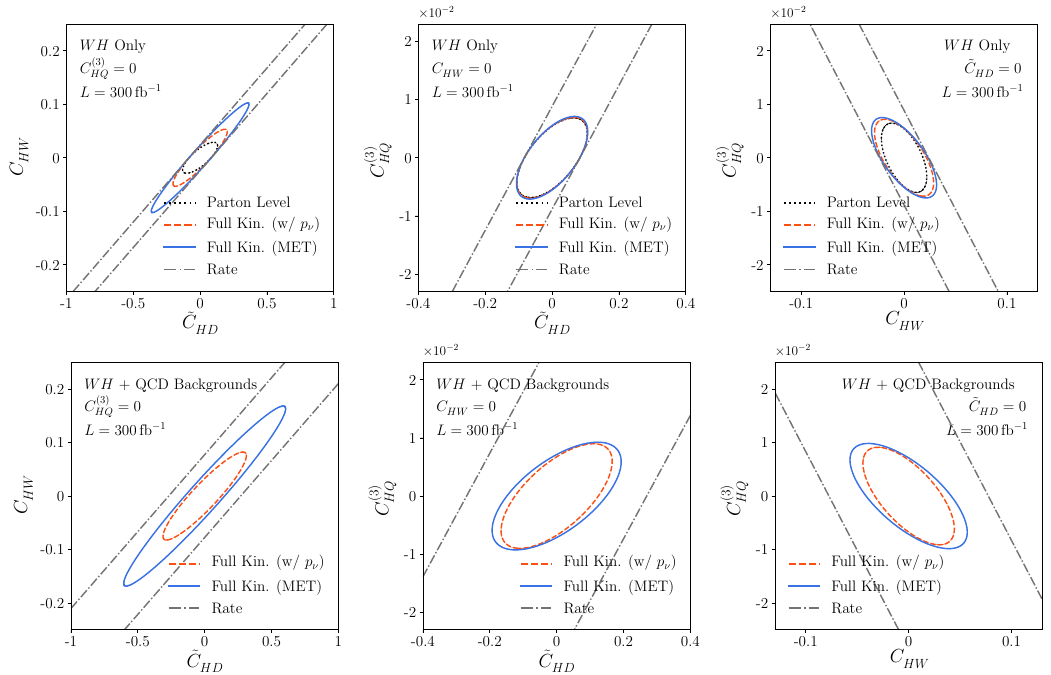
Figure 1 . 95% CL limits based on the (linearized) Fisher information on pairs of Wilson coe(cid:14)cients with (cid:3) = 1 TeV, for WH production only (top) and including the QCD background (bottom). We include full parton-level information without detector e(cid:11)ects (dotted black), detector e(cid:11)ects, but retaining the full neutrino 4-momentum (dashed orange), and (cid:12)nally retaining only the transverse neutrino momentum (solid blue). We also show the information using only the signal rate in